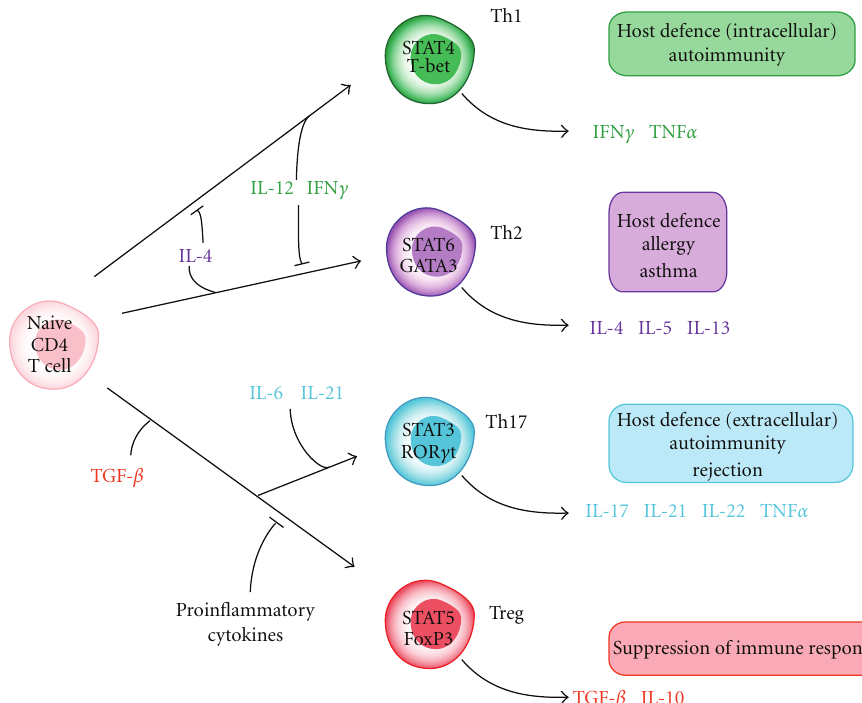
Figure 1: Di ff erentiation of CD4 + T-cell subsets (in mice). Upon activation, na¨ıve CD4 + T cells can di ff erentiate into di ff erent subsets depending on the surrounding cytokine milieu. The di ff erent subpopulations show distinct expression patterns of transcription factors and can be characterized by secretion of signature cytokines that are unique for each subset. Each subset takes part in di ff erent kinds of immune responses against various pathogens or in mediating